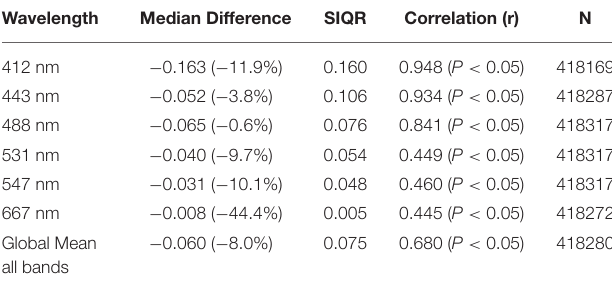
TABLE 2 | Statistics on the comparison of global normalized water-leaving radiances L w N( λ ) from the NOBM-OASIM model and radiances from MODIS-Aqua for